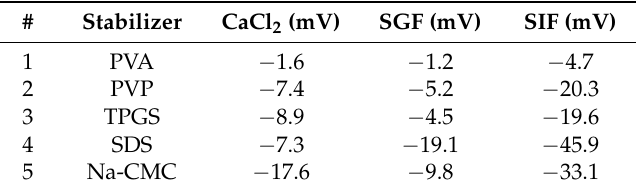
nanosuspension preserved with SDS and Na-CMC.